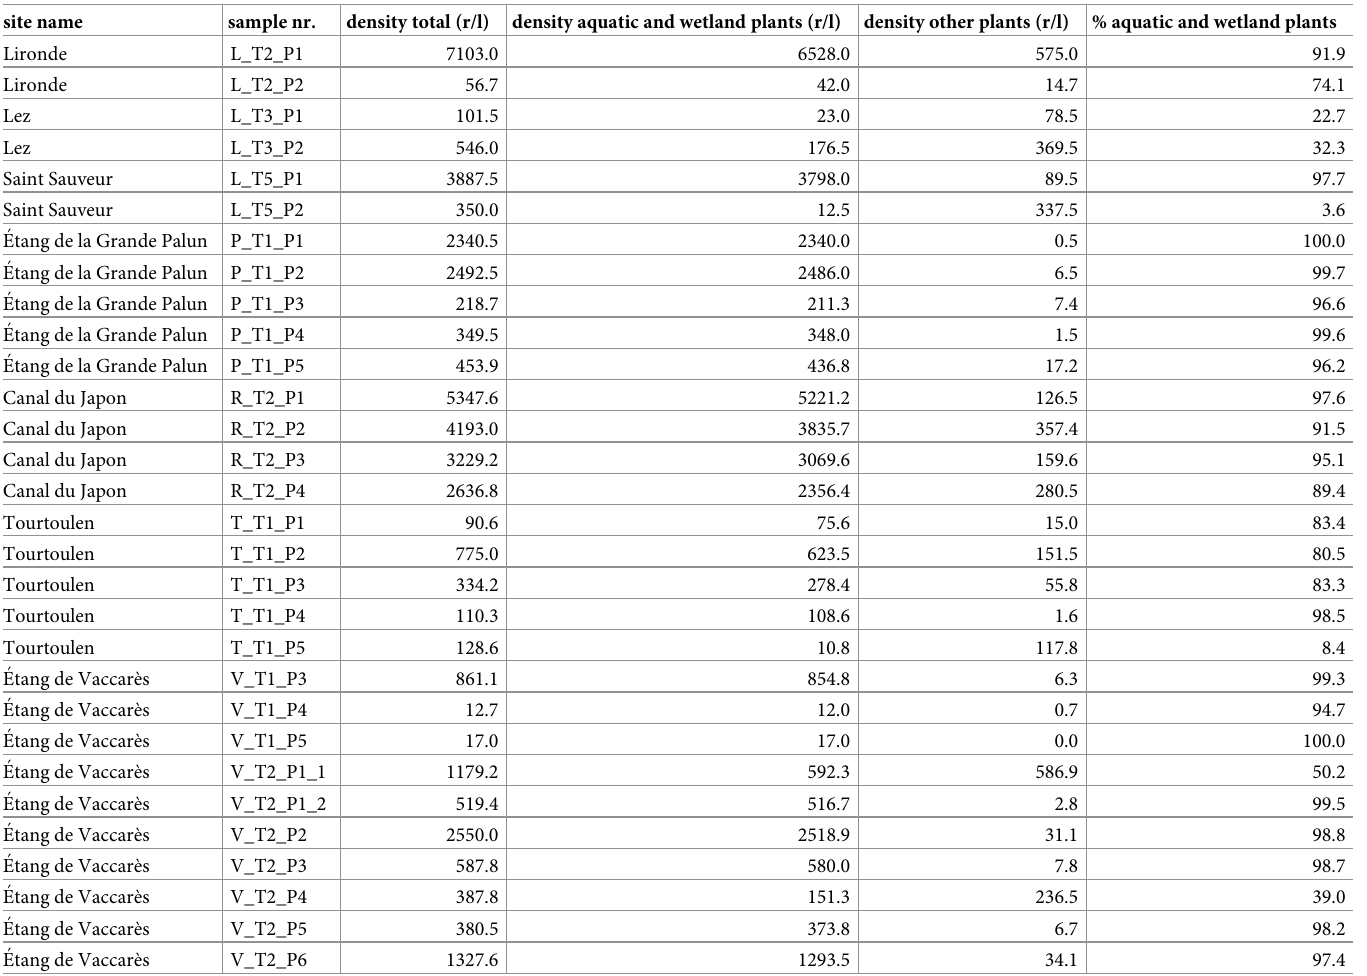
Table 1. Densities and percentages of plant remains in the modern analogue samples. site name sample